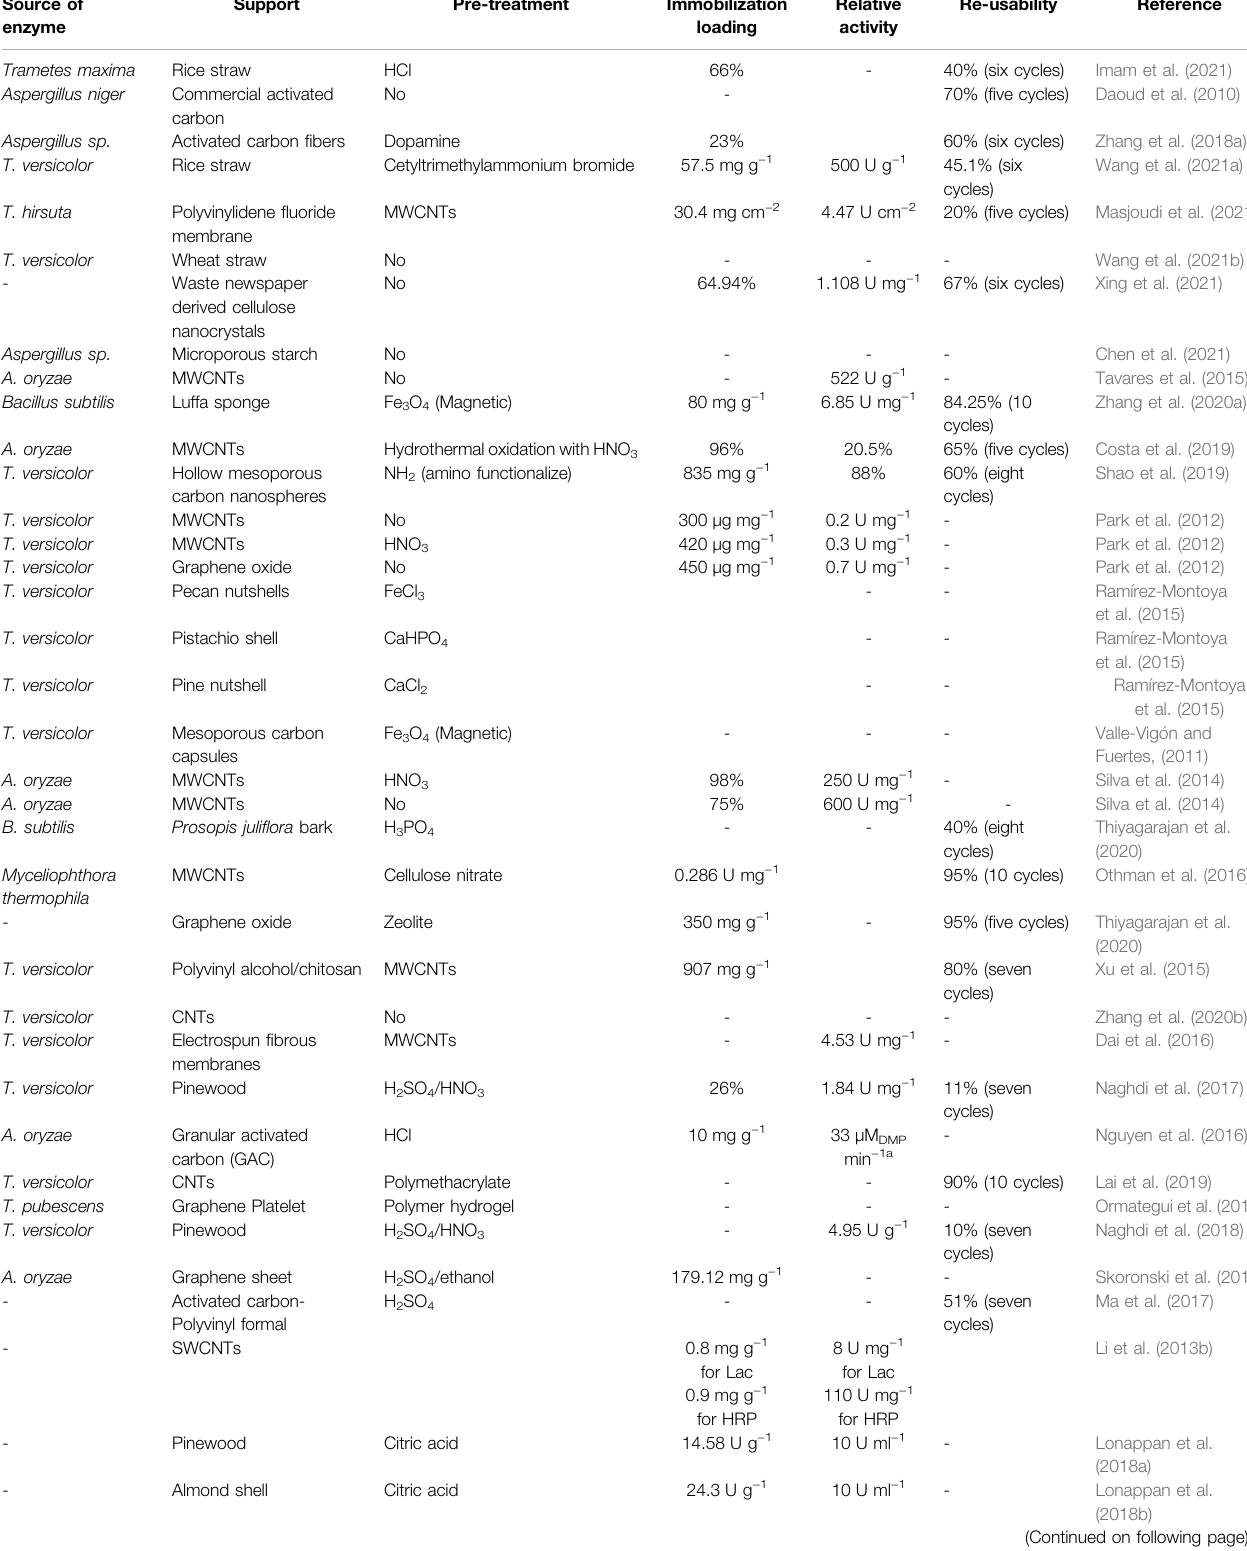
TABLE 4 | Immobilization of laccase on carbon-based